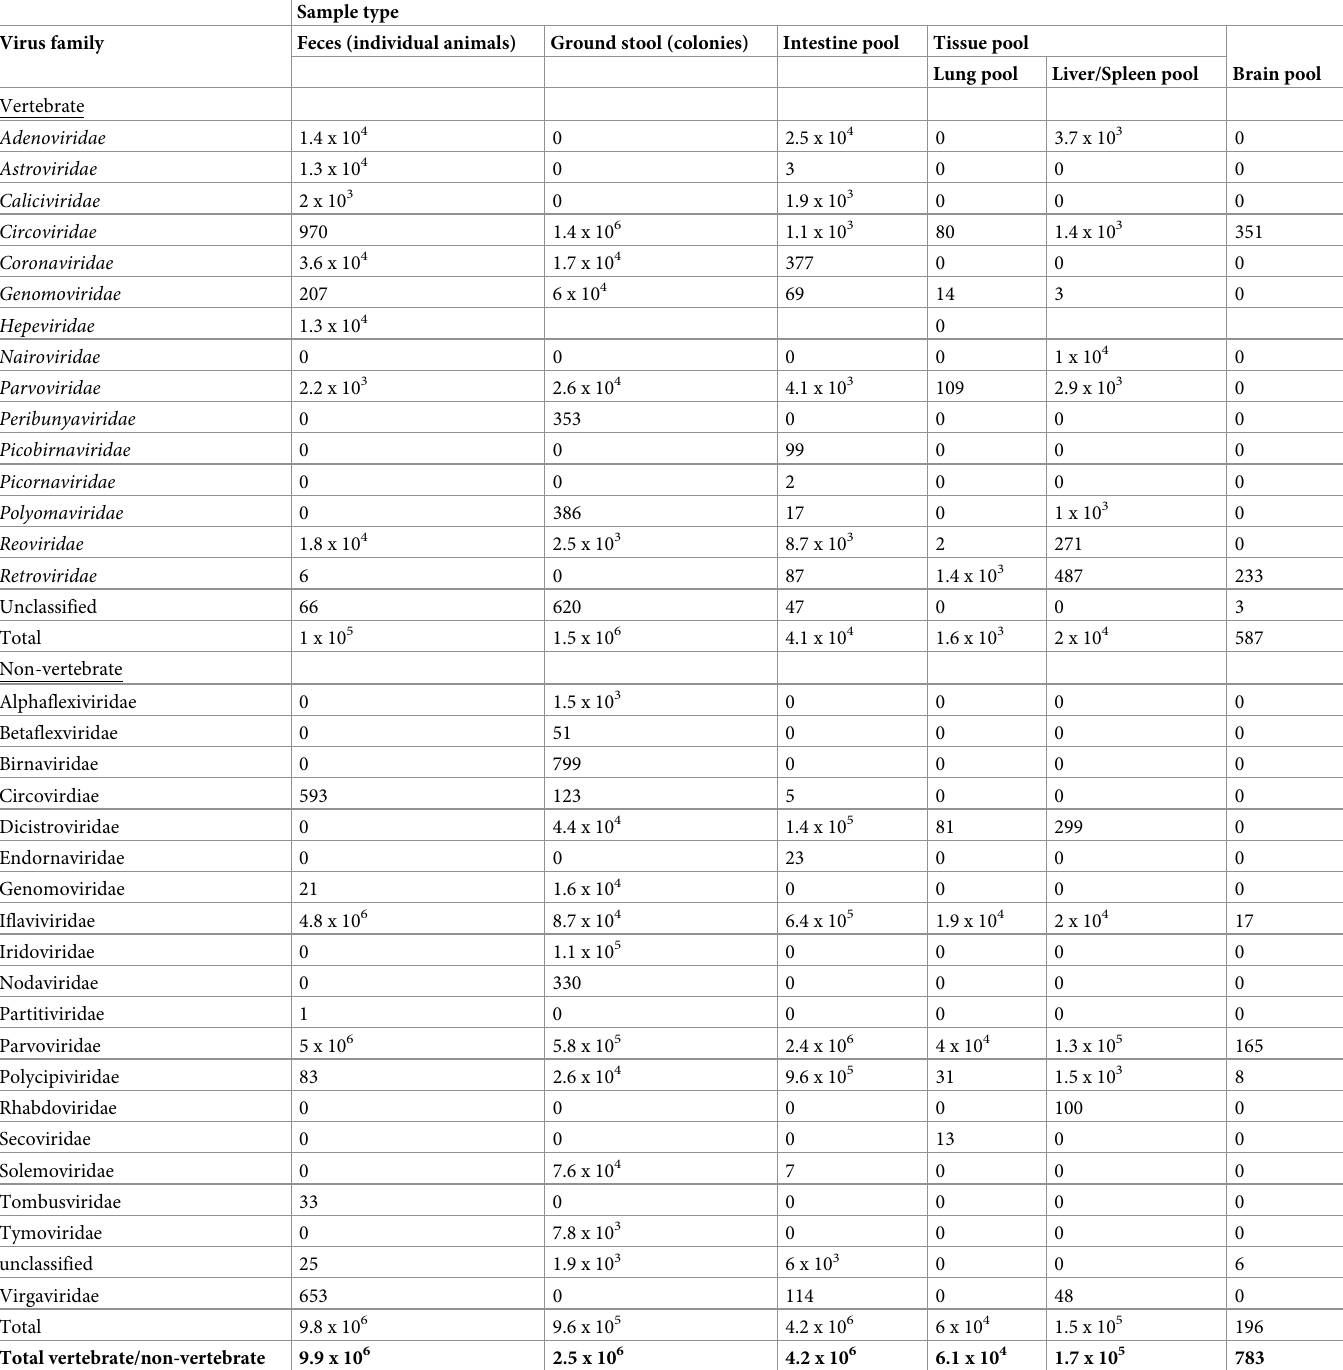
Table 2. Overview of reads assembled to different virus families categorized by sample